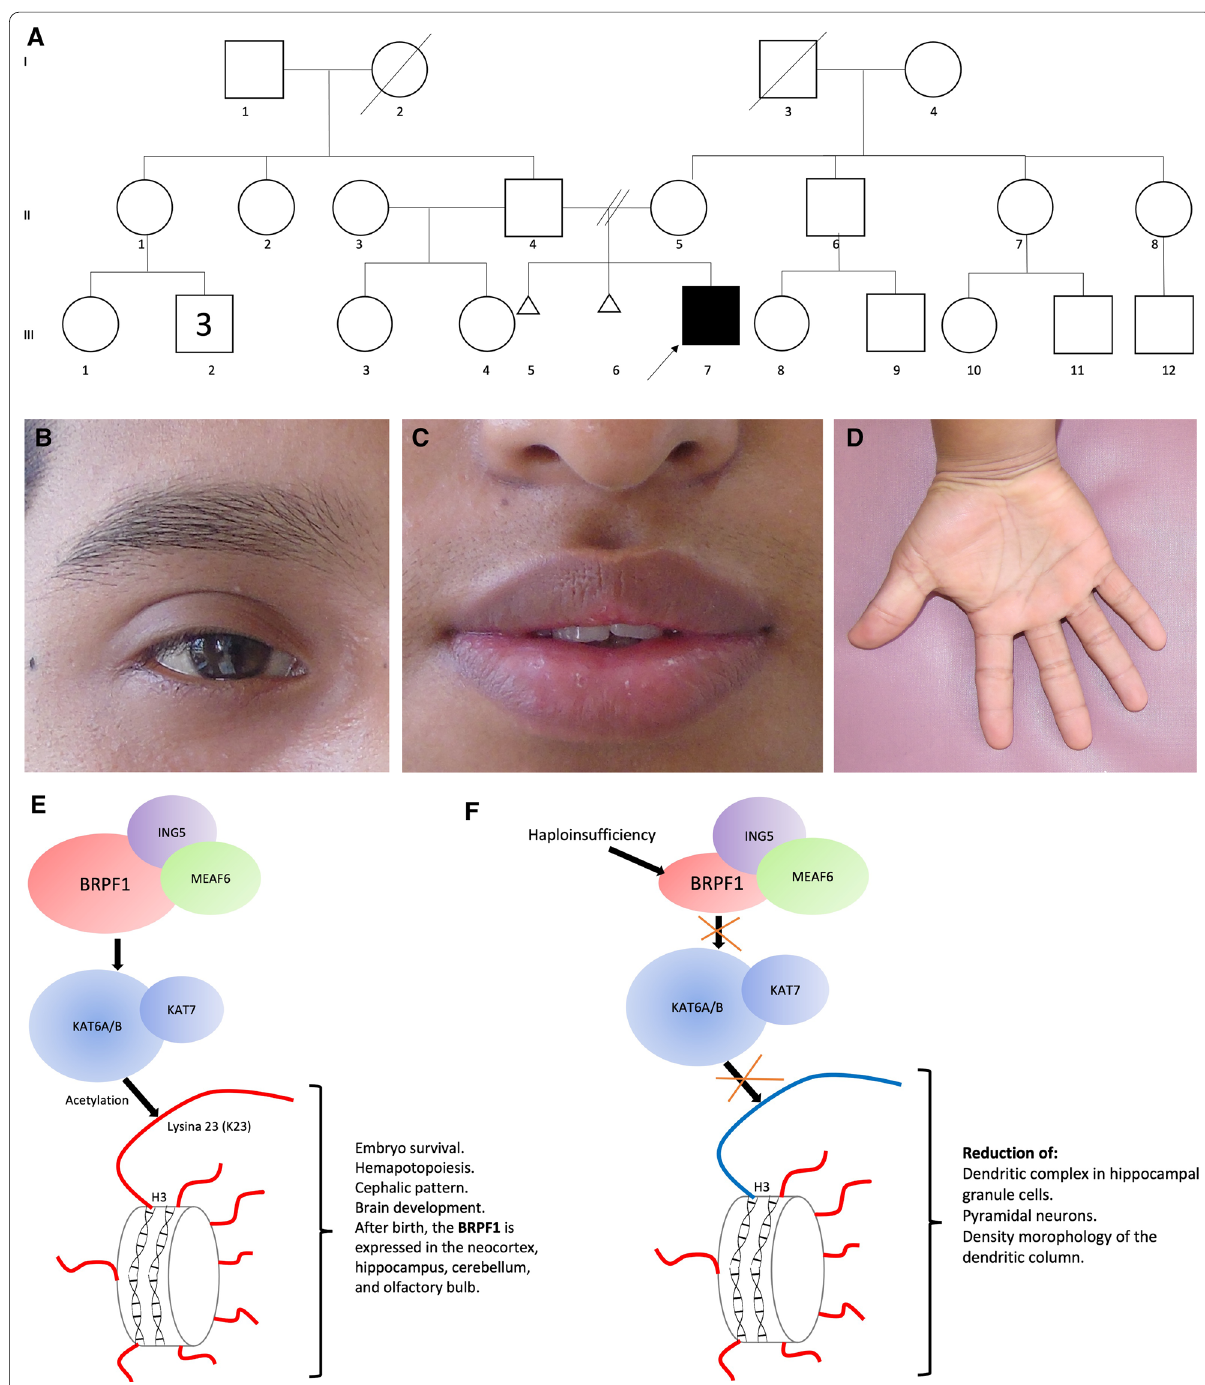
Fig. 1 A Pedigree indicated a de novo variant (III.7) in this family, paternal and maternal ancestry are from different regions B Palpebral ptosis, bilateral epicanthus, blepharophimosis, C Prominent columella, short philtrum, thick vermilion of the lips. D Brachydactyly and decrease in the distal interphalangeal crease of the fourth finger. E Normal function of BRPF1 gene (peregrin). F Haploinsufficiency of BRPF1 produces a reduction of various processes in the brain. BRPF1 Bromodomain‑ and PHD finger‑ containing protein. ING5 = Esa1‑associated factor 6. KAT6A/B Lysine acetyltransferase 6A and 6B. KAT7 ( HBO1 ) =